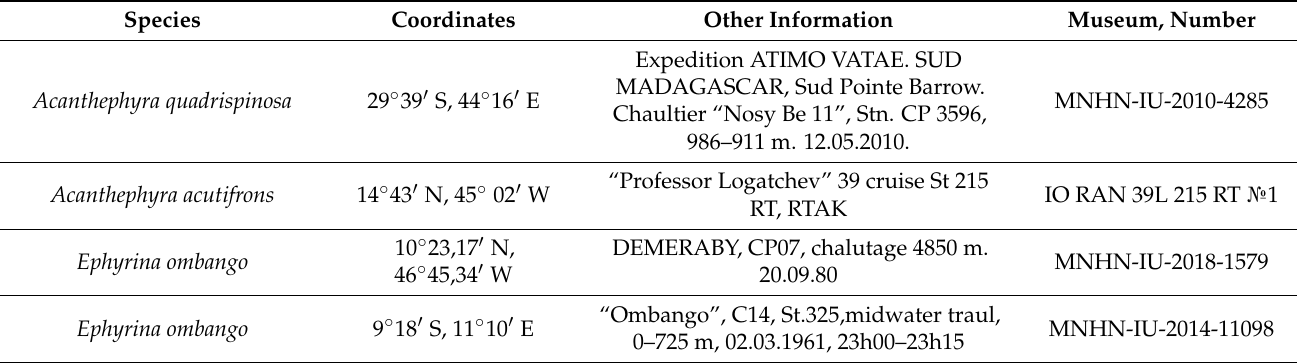
Table 1. Individuals used in morphological analyses. MNHN - National Museum of Natural History (Paris, France); ZMUK—National History Museum, Copenhagen, Denmark; IO RAN—Institute of Oceanology, Russian Academy of Scienses, USNM -National Museum of Natural History, Smithsonian